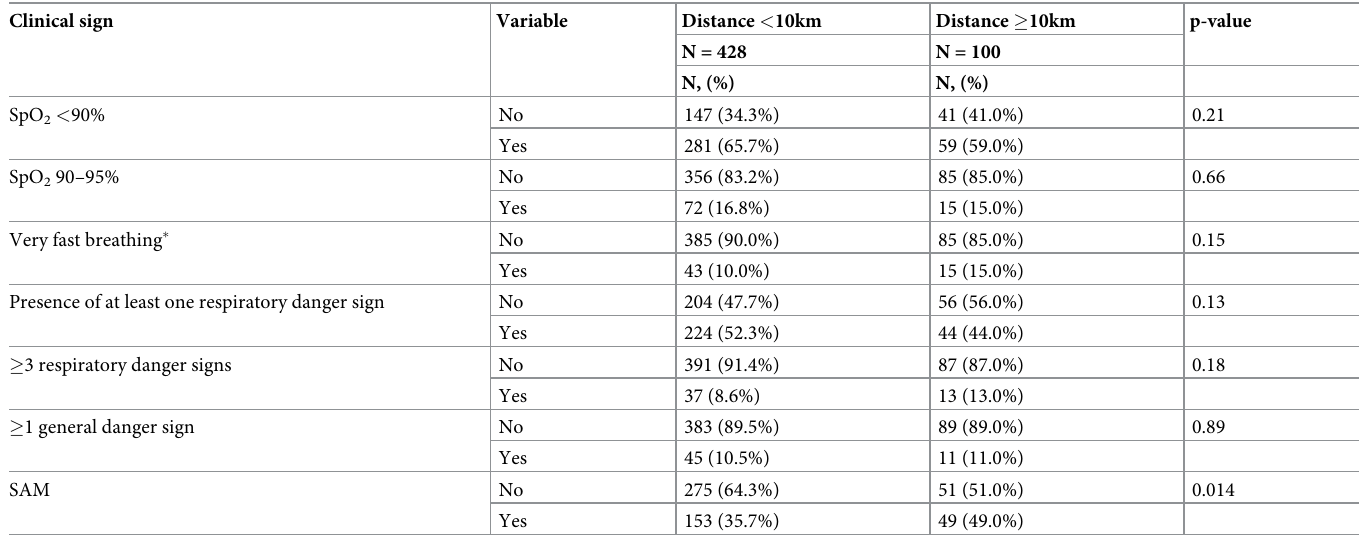
Table 3. Clinical signs of severe pneumonia and malnutrition at the time of hospitalization according to participant distance from the nearest health facility. Clinical